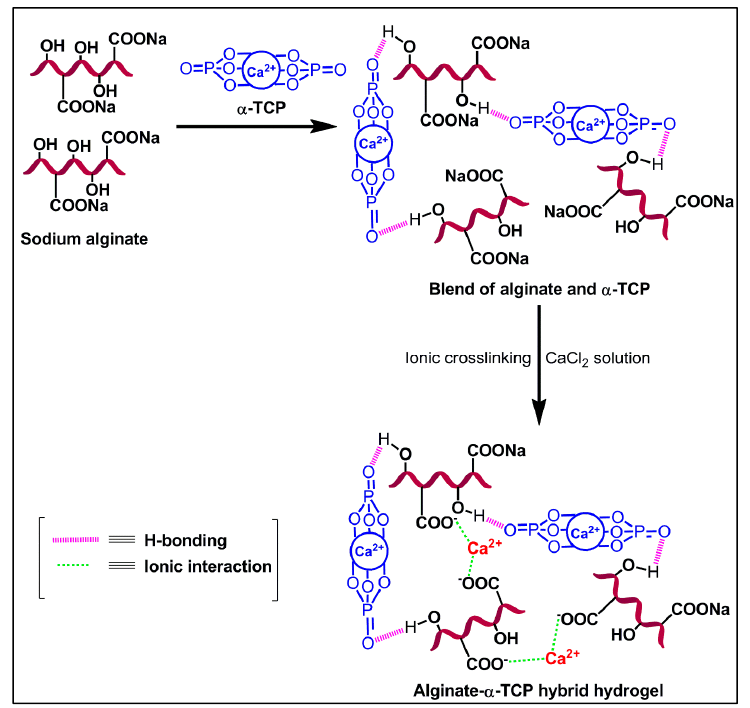
Figure 3. Schematic of probable reaction mechanism for Alg- α -TCP hybrid gel formation.